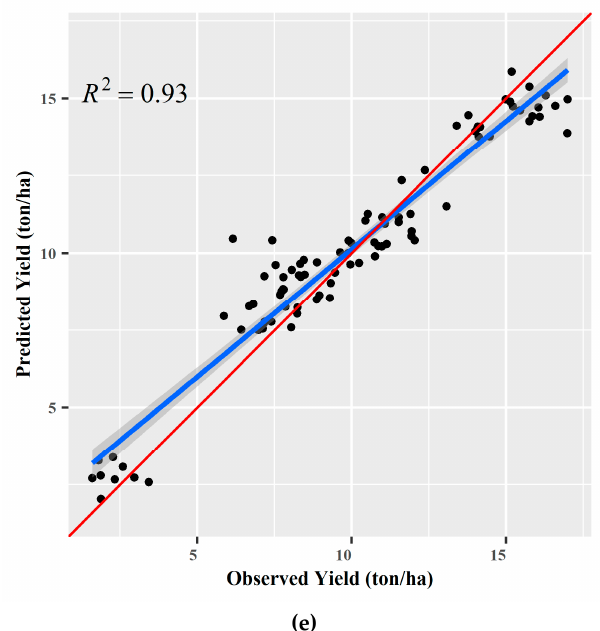
Figure 11. Scatter plot of observed versus predicted yield model of corn using multiple linear regression: ( a ) V3 (3 leaves with visible leaf collar); ( b ) V4-5; ( c ) V6-7; ( d ) V10; ( e ) VT stages.